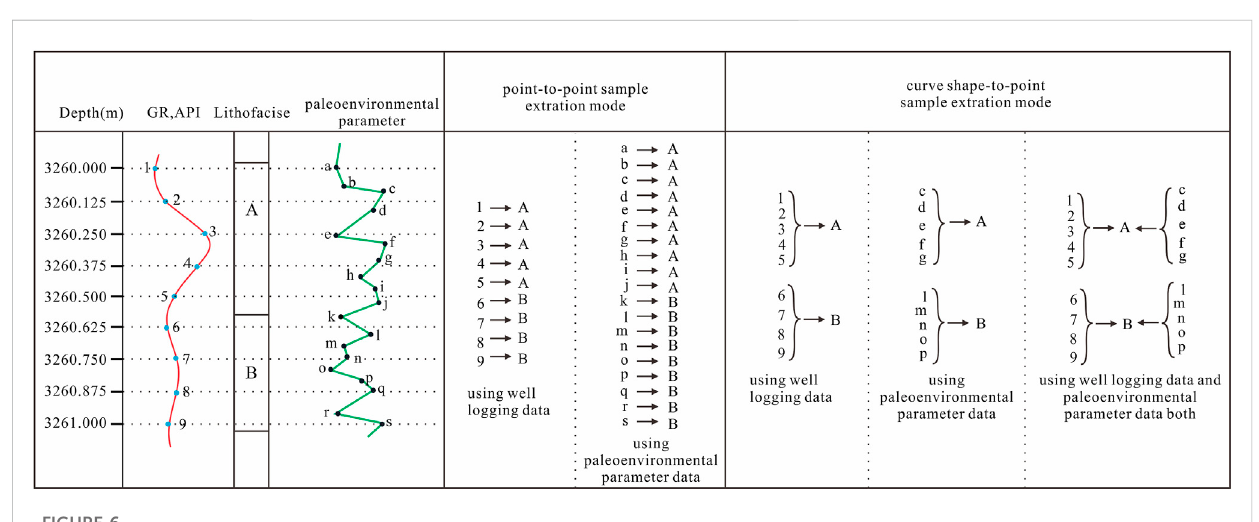
FIGURE 6 Sketch of point-to-point and curve shape-to-point sample extraction